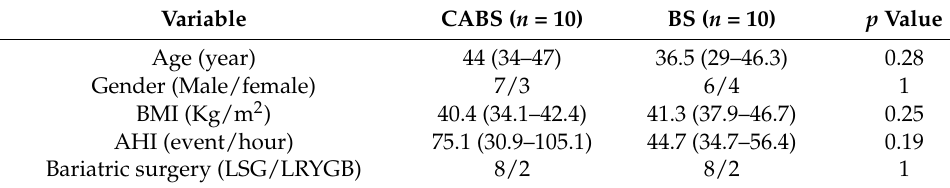
Table 1. Baseline anthropometric, polysomnographic and surgical